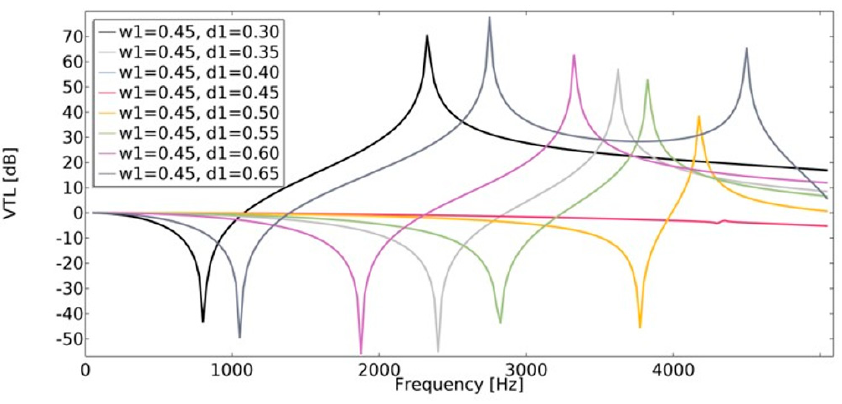
Figure 23. The influence of geometric features on the value of VTL for w 1 = 0.45.